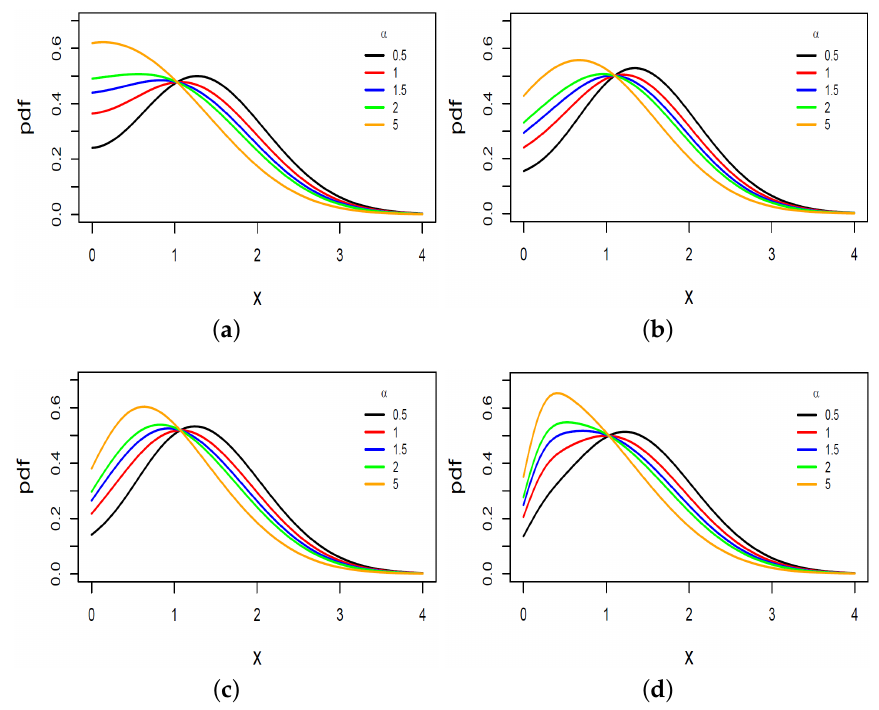
Figure 2. ( a ) Pdf of EHSN ( α , δ = 1, λ = 0.1) for different values of α . ( b ) Pdf of EHSN ( α , δ = 1, λ = 1) for different values of α . ( c ) Pdf of EHSN ( α , δ = 1, λ = 2) model for different values of α . ( d ) Pdf of EHSN ( α , δ = 1, λ = 5) model for different values of α